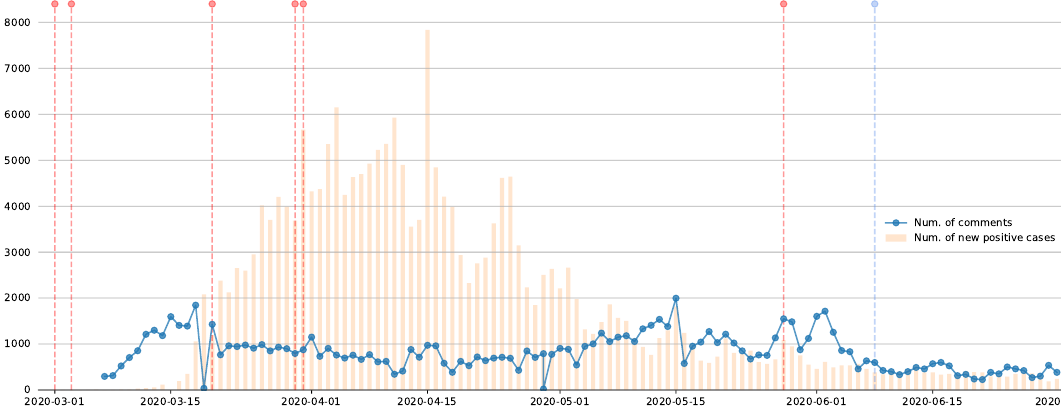
Figure 9. Number of comments per megathread in /r/unitedkingdom compared to the number of new daily cases in UK. Vertical lines represent adopted critical events and policies.